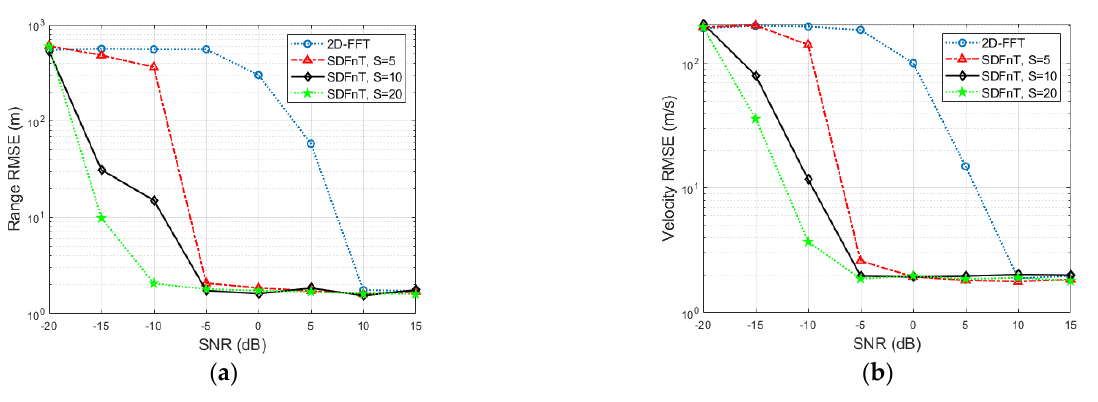
Figure 2. Estimation accuracy comparison in terms of SNR ( a ) RMSE for the range estimation ( b ) RMSE for the velocity estimation.